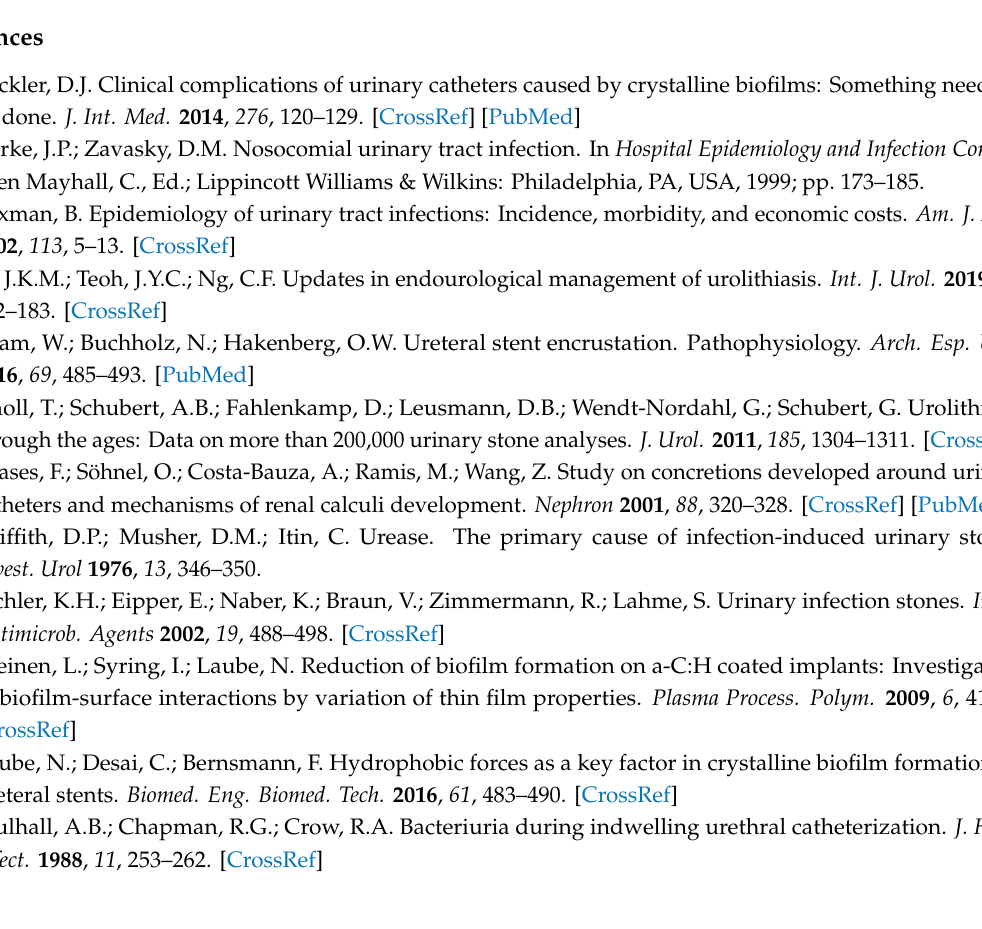
Figure S1: pH of synthetic urine: pH measurements of the synthetic urine inside the reaction chamber of the in vitro encrustation system; Figure S2: Contact angle: Contact angle of the various polymers measured with synthetic urine at di ff erent pH values; Figure S3: EDX analyses: Overview of the mineral deposits on the polymer surfaces; Figure S4: FTIR measurements of the mineral deposits on the polymer